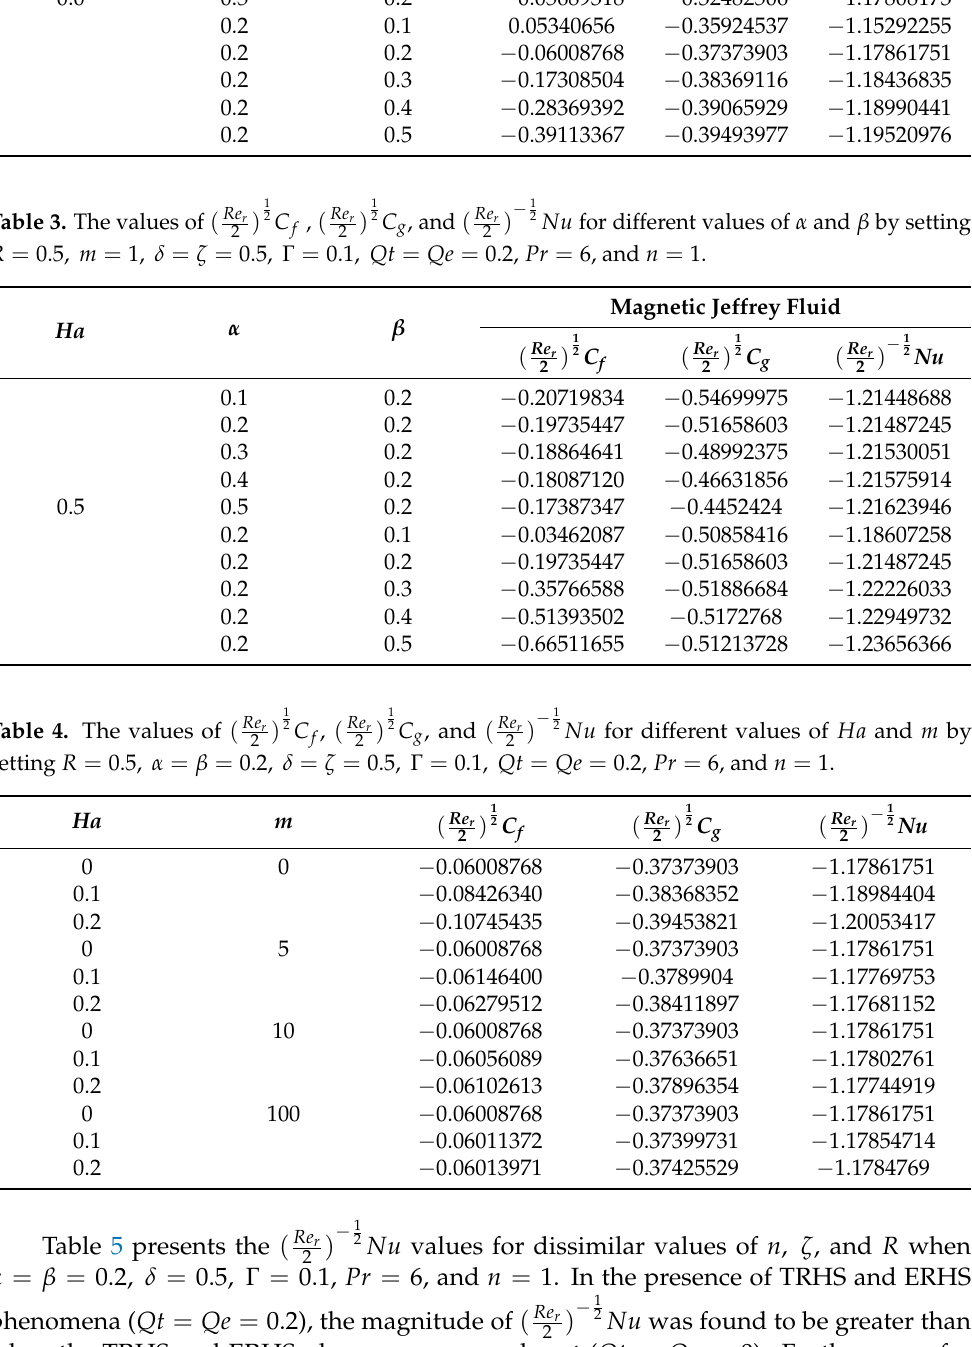
Table 3. The values of ( Re r